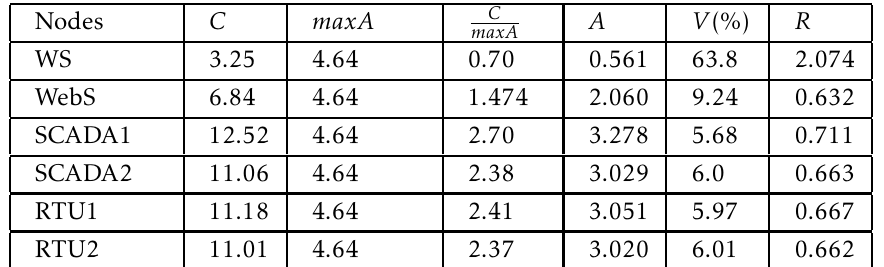
Table 6. Exponential Cost Resource Allocation ( λ = 0 . 53